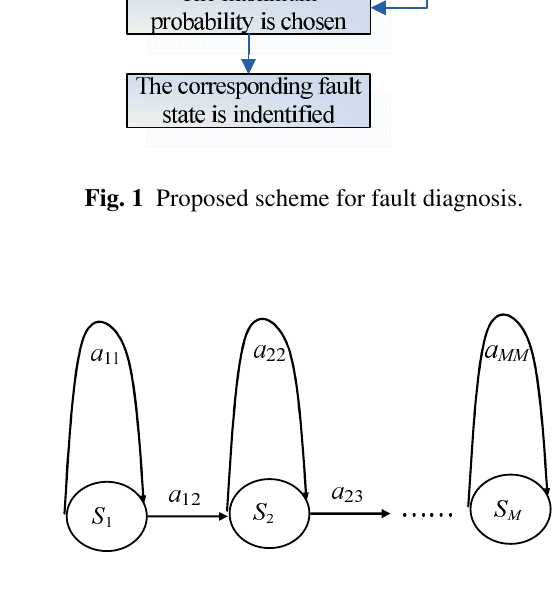
Fig. 2 M-state left-to-right